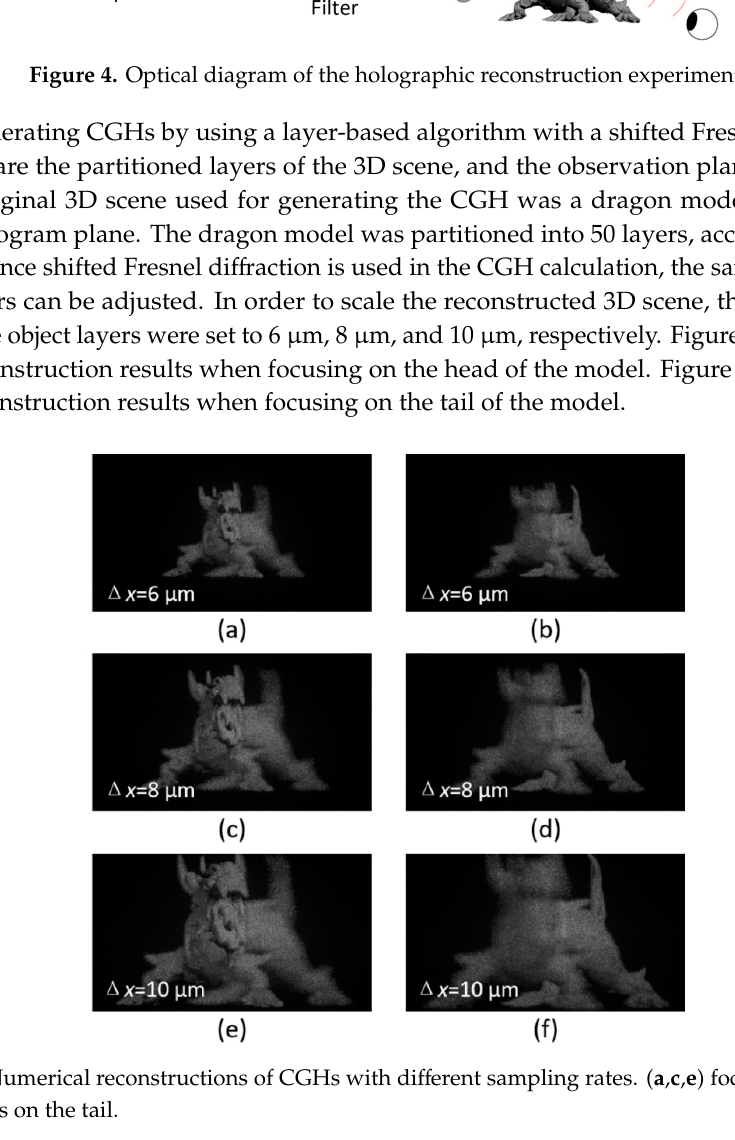
Figure 5. Numerical reconstructions of CGHs with different sampling rates. ( a ), ( c ) and ( e ) focus on the head; ( b ), ( d ) and ( f ) focus on the tail.